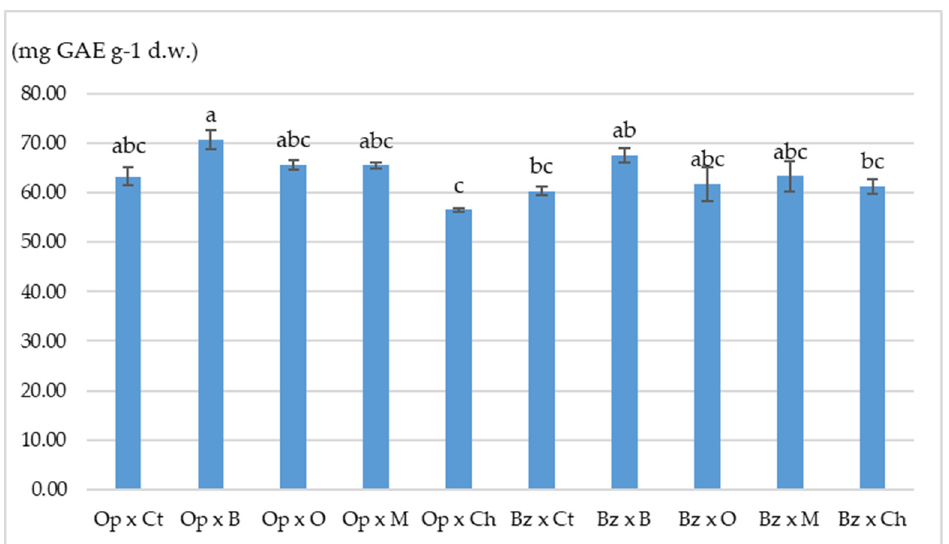
Figure 2. Total phenolics content in basil leaves, as a ff ected by the interaction between cultivar and fertilization. Opal (Op); De Buzau (Bz); control (Ct); biosolids (B); organic (O); microorganisms (M); chemical (Ch). Values associated with di ff erent letters are significantly di ff erent according to Tukey’s test at p <